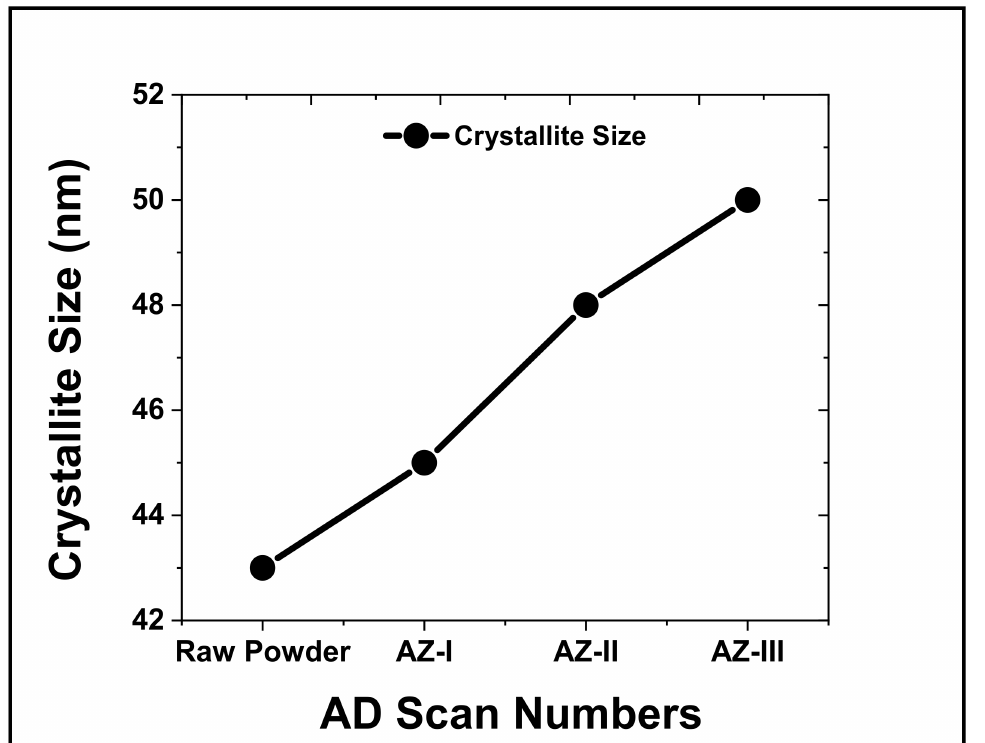
Figure 4. Crystallize size of ZnO powder and the aerosol-deposited ZnO